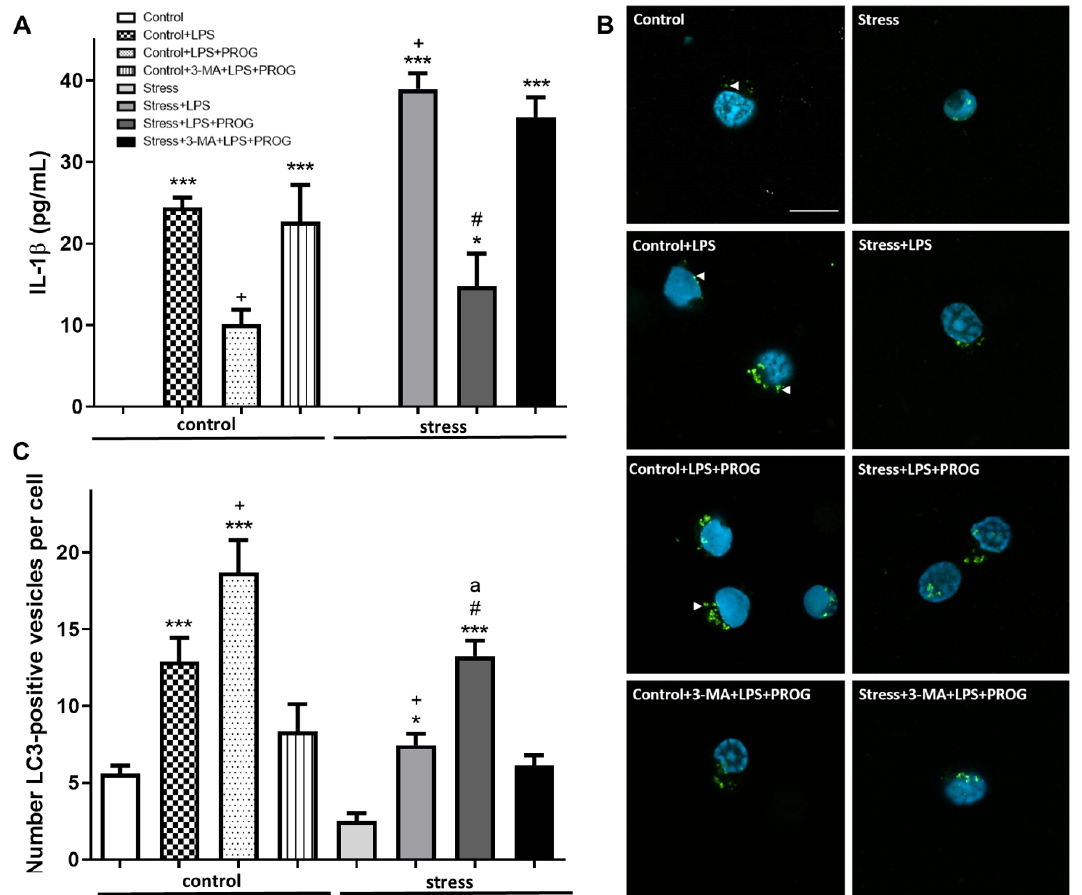
Figure 6. Autophagy impairment in stress-primed microglia. Hippocampal microglia were isolated from male adult rats that have experienced prior stress, or from unstressed controls. Then, cells were stimulated ex vivo with LPS (10 ng/mL) and concomitantly treated with PROG (20 μM). Pre-treatment with 3-MA (5 mM) was used to inhibit autophagy. ( A ) IL- 1β levels in the culture supernatant , as measured by ELISA [ANOVA F(7, 16) = 34.51, p < 0.0001] . ( B ) Representative immunofluorescence for LC3-positive vesicles (white arrowheads) in microglia isolated from unstressed controls (left panel) and stressed animals (right panel). ( C ) Average number of LC3-positive vesicles per cell in each condition [ANOVA F(7, 230) = 21.08, p < 0.0001] . Scale bar: 10 μm. Data are expressed as mean ± SEM. N = 3 replications. * p < 0.05, *** p < 0.001, vs. Control; + p < 0.05 vs. Control+LPS; # p < 0.01 vs. Stress+LPS; and a p < 0.05 vs. control+LPS+PROG.